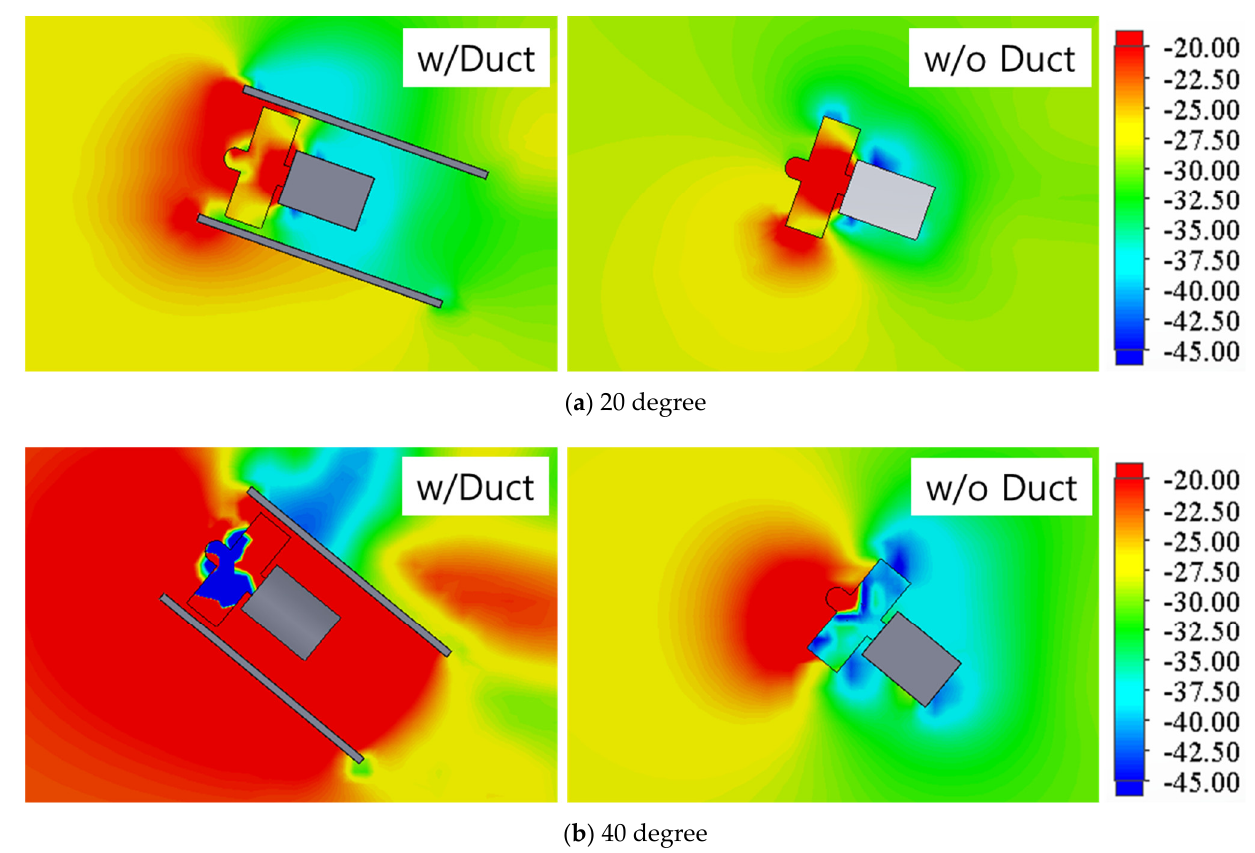
Figure 4. Comparison of wind pressure (Pa) for wind direction change.